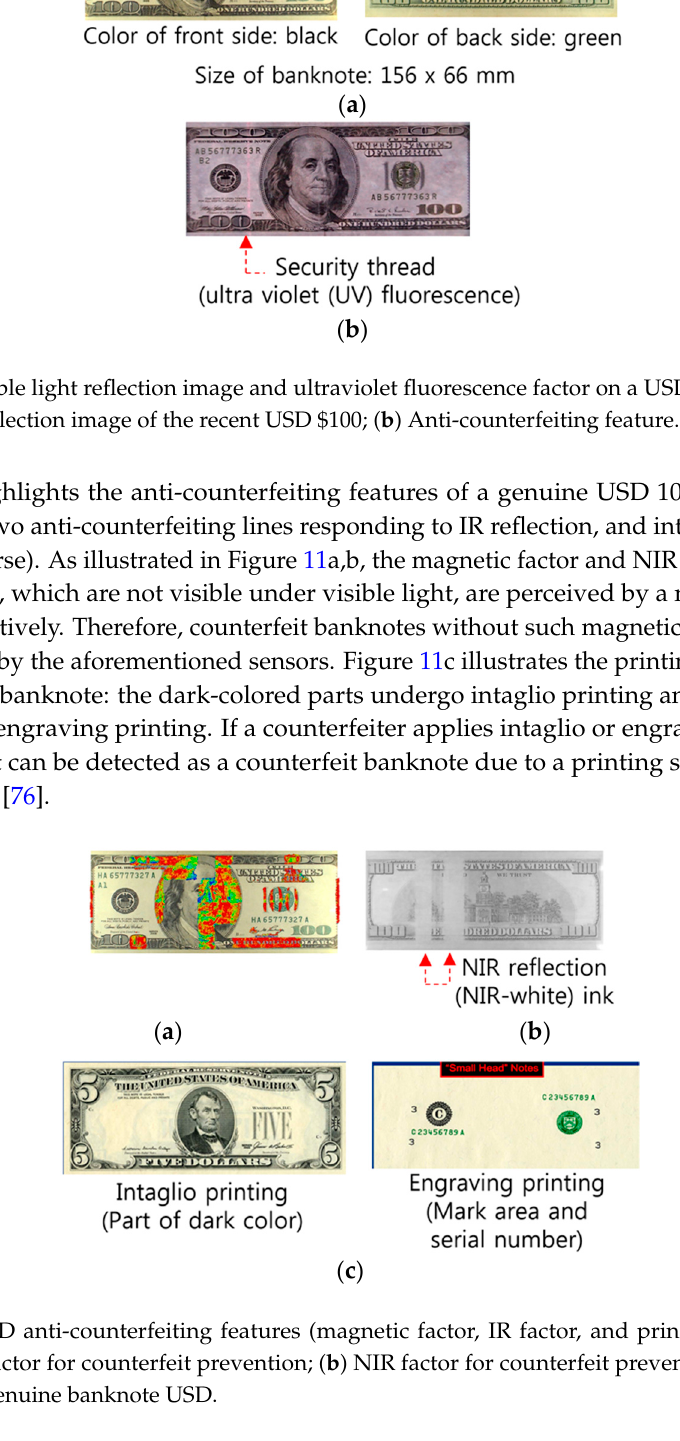
Figure 10. Visible light reflection image and ultraviolet fluorescence factor on a USD 100 bill: ( a ) The visible light reflection image of the recent USD $100; ( b ) Anti-counterfeiting feature.